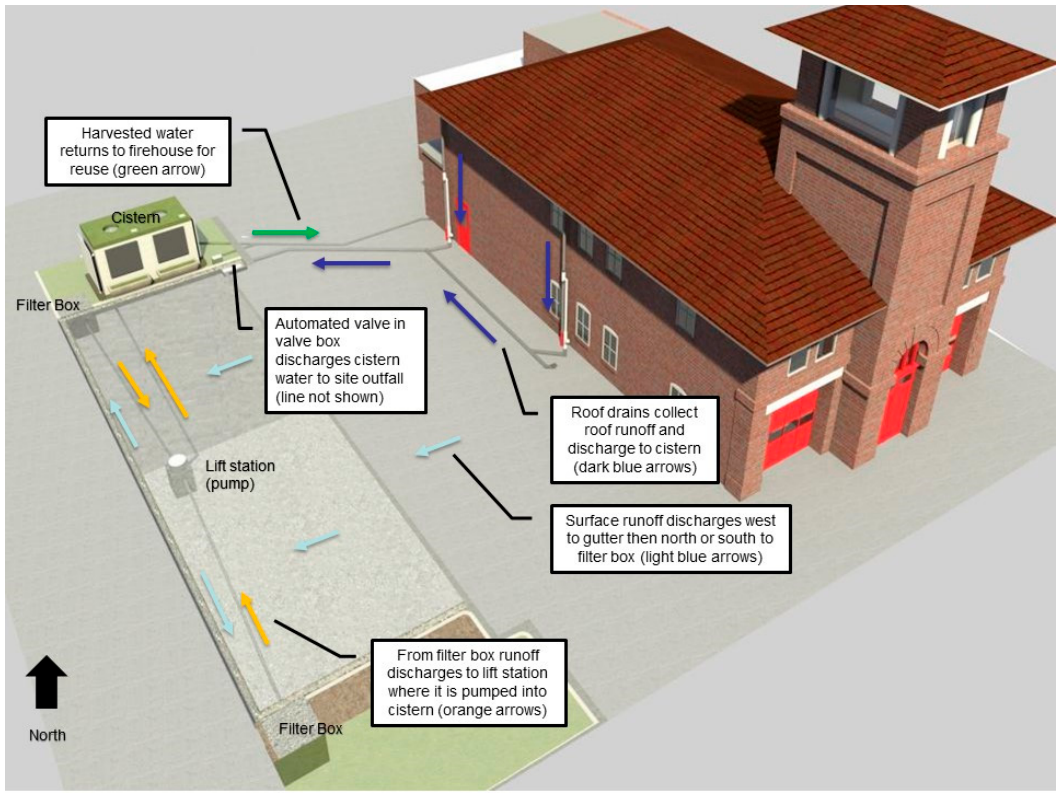
Figure 4. System configuration for Engine House 25.